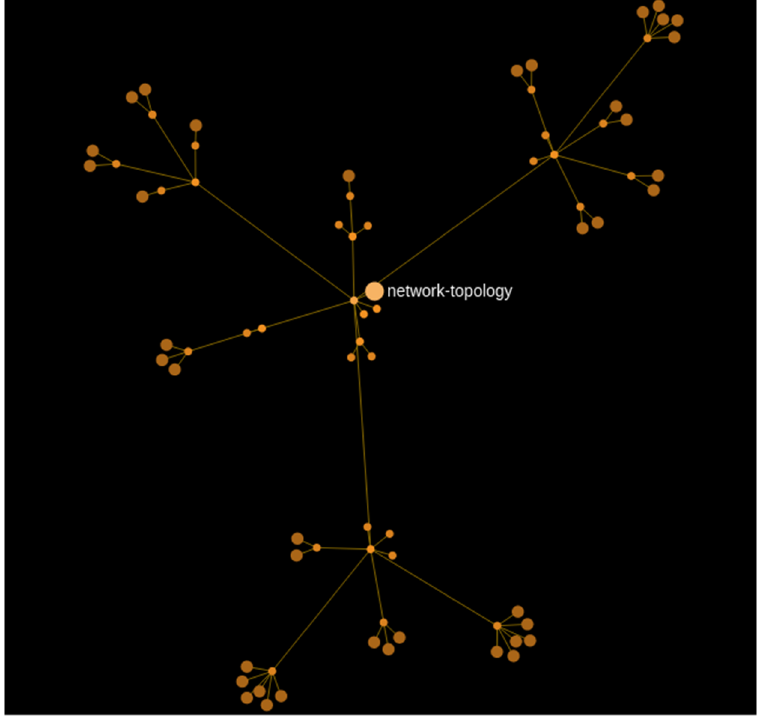
Figure 25. Model is network topology on yang ‐ visualizer on DLUX console.